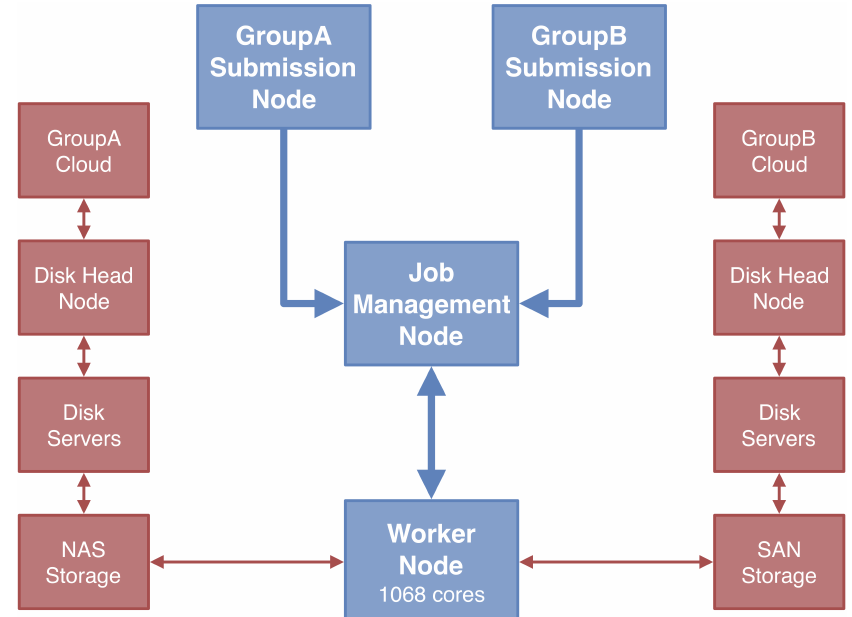
Figure 4. The job management node in the center of the figure and the worker node below it are shared by the two groups, but the job submission node (UI) and storage system are separately